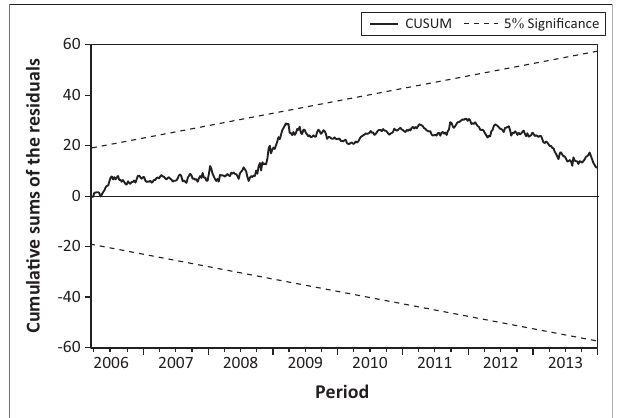
FIGURE 2: Cumulative sum control chart.